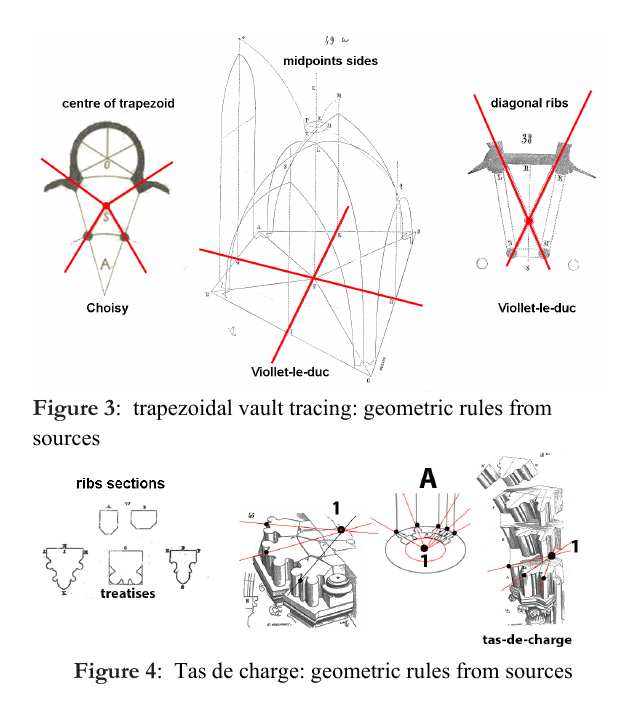
Figure 5 : Apses tracing – Choisy 1889